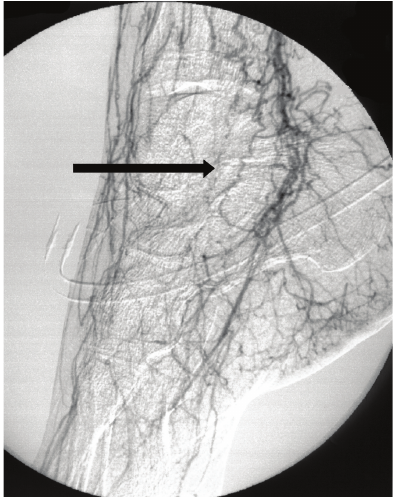
Figure 3: Intraoperative arteriography showing the distal occlusion of right tibial and peroneal arteries, with the typical “corkscrew” collateral arteries (black arrow), suggestive of a